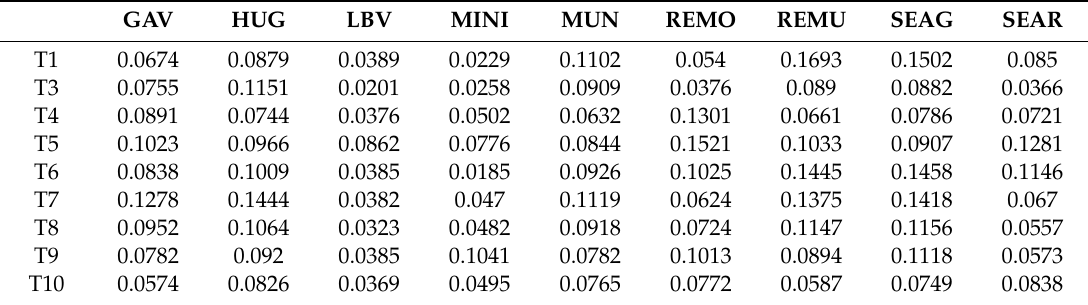
Table 9. The similarity between each pair of nodes in the technology and product layers.